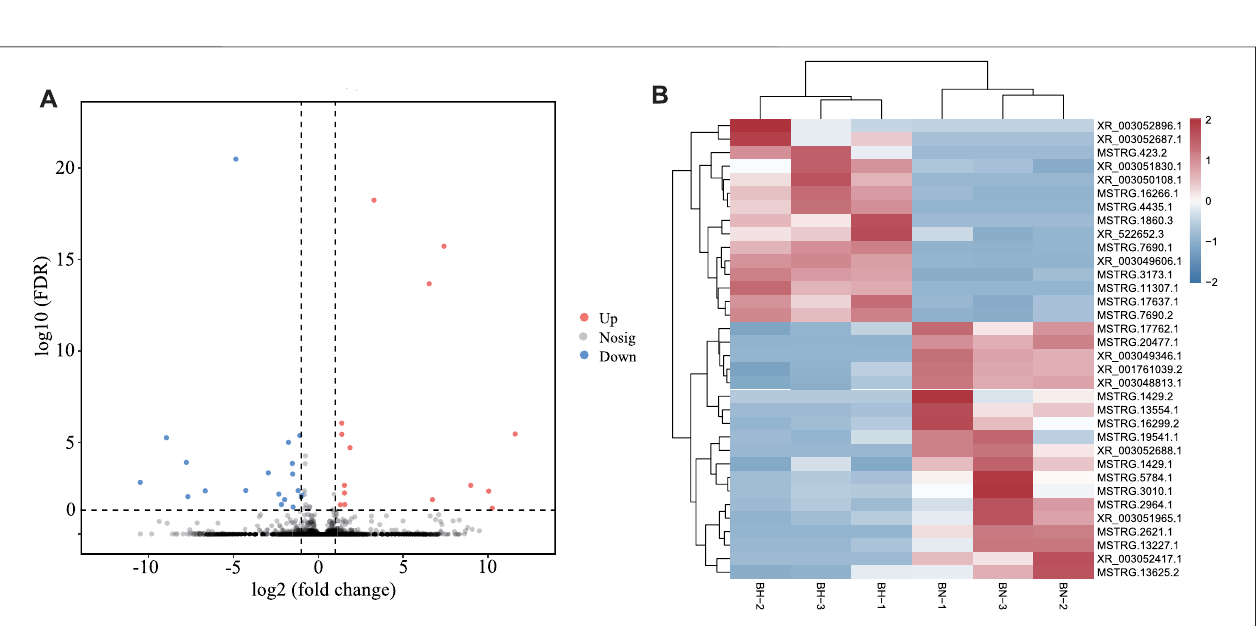
FIGURE5|(A) VolcanoplotsfordifferentiallyexpressedlncRNAsbetweenBNandBHskin. (B) HeatmapofdifferentiallyexpressedlncRNAsbetweenBNandBH.